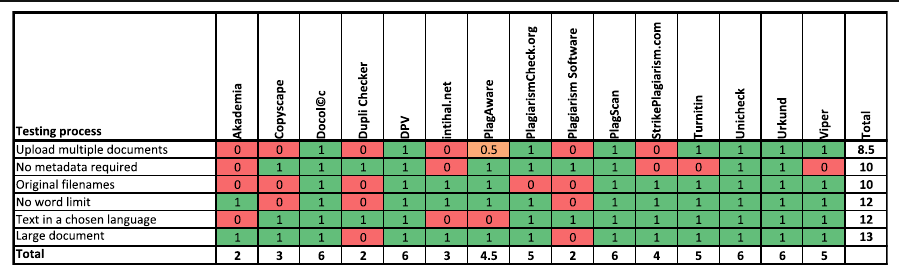
Table 9 Usability evaluation: Workflow process